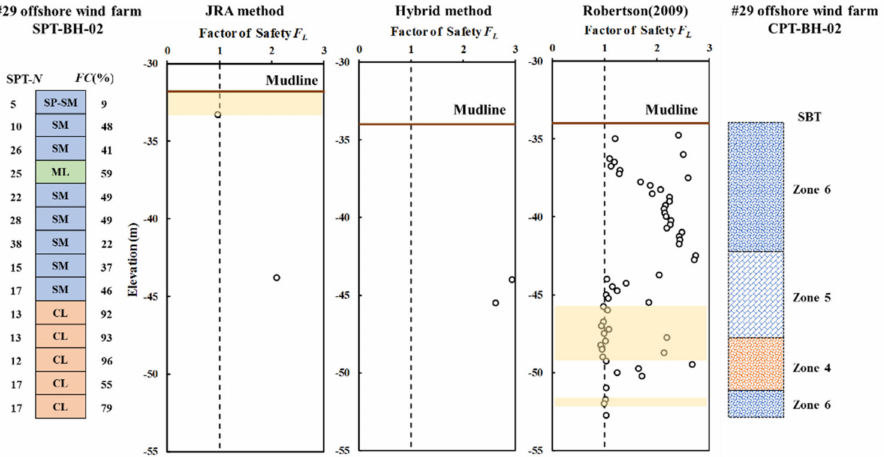
Figure 10. The soil liquefaction potential of boreholes CPT-BH-02 and SPT-BH-02 in #29 offshore wind farm.